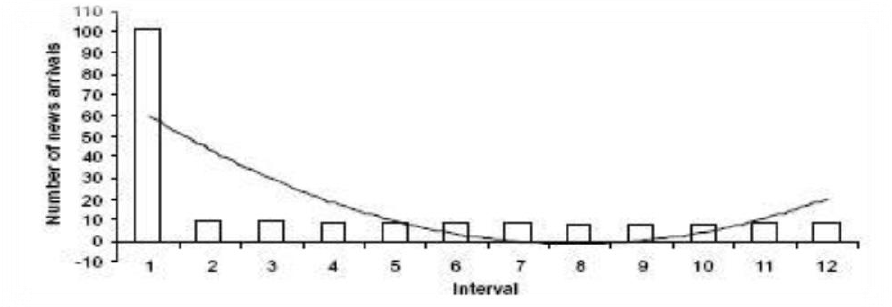
Figure 2. The Histogram for the Number of New Events Occurring during One Trading